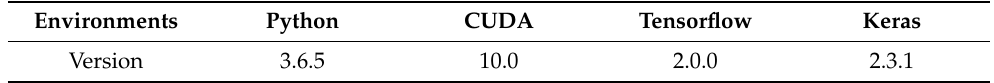
Table 4. Local training